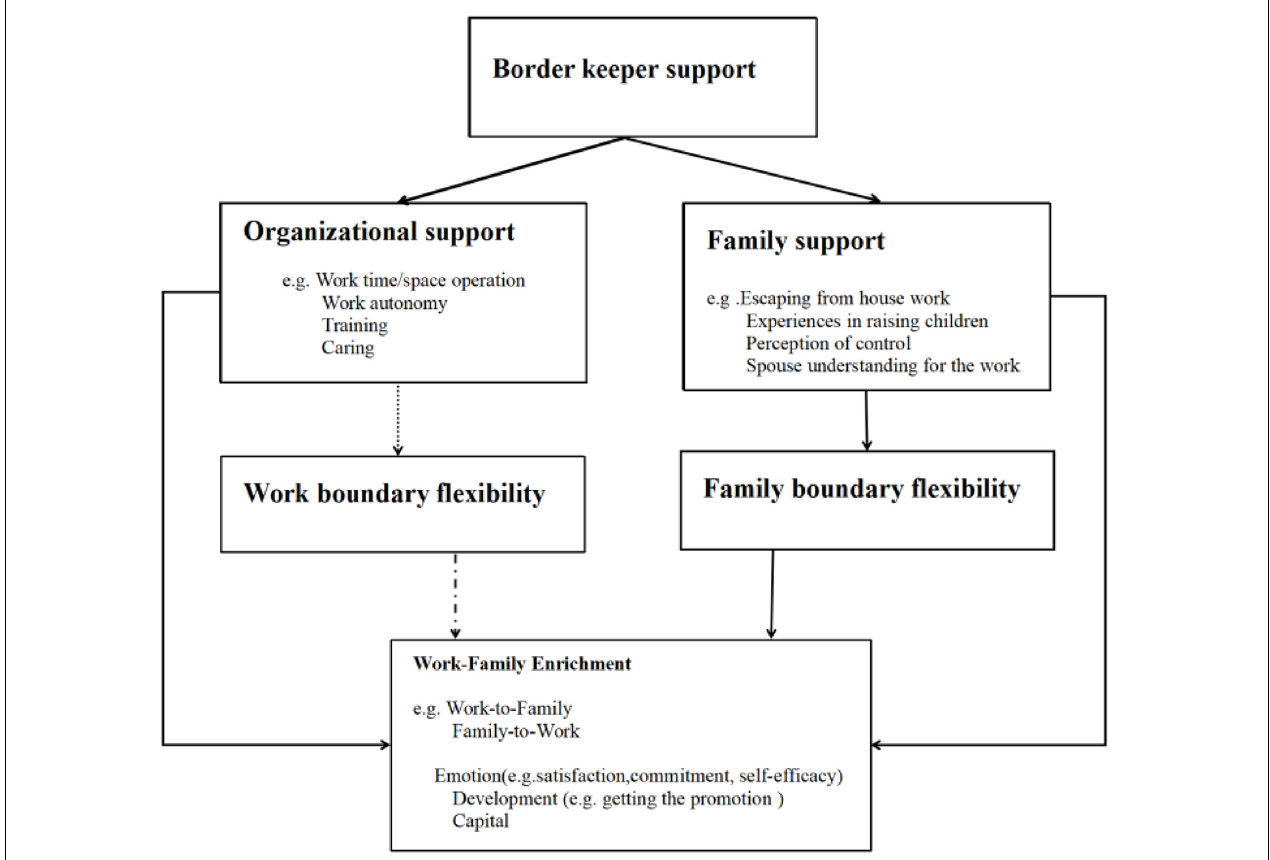
FIGURE 4 | Theoretical mechanism between border keepers’ support and work-family